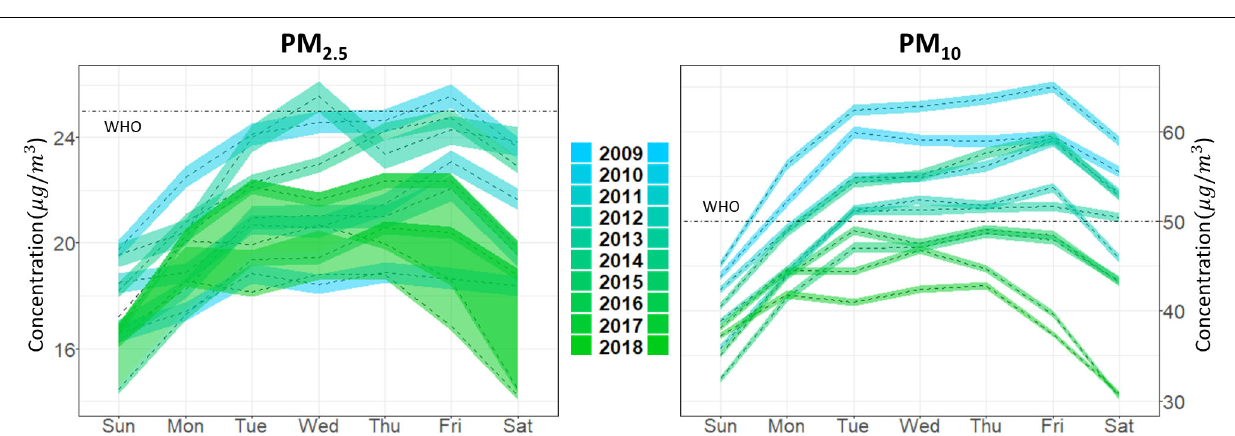
Frontiers in Environmental Science |